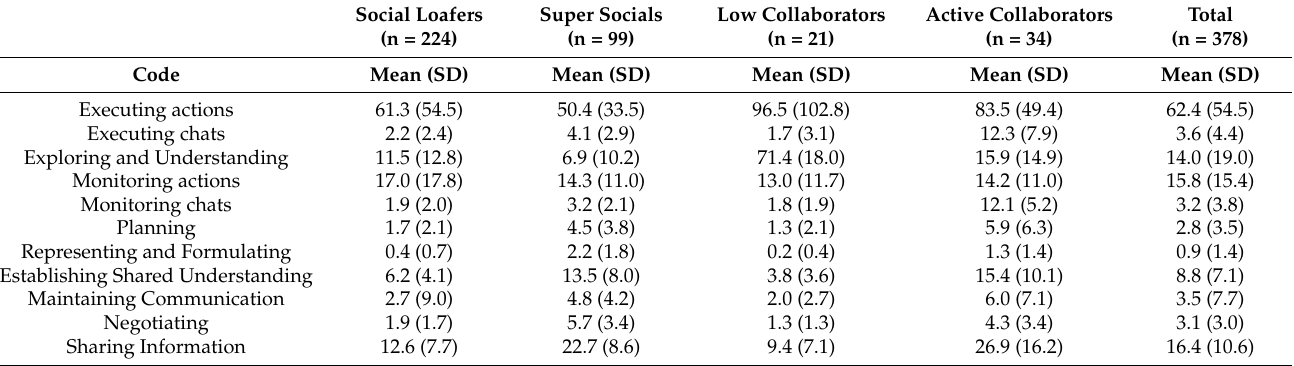
Table 4. Descriptive statistics for average frequencies of human CPS codes for each cluster and